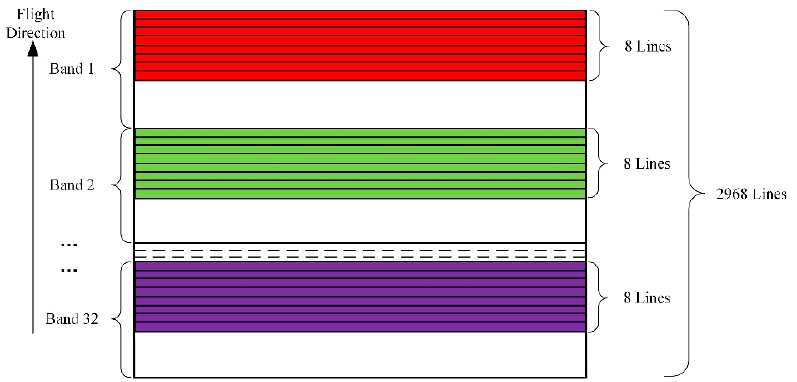
Figure 3. Sensor spectrum distribution.